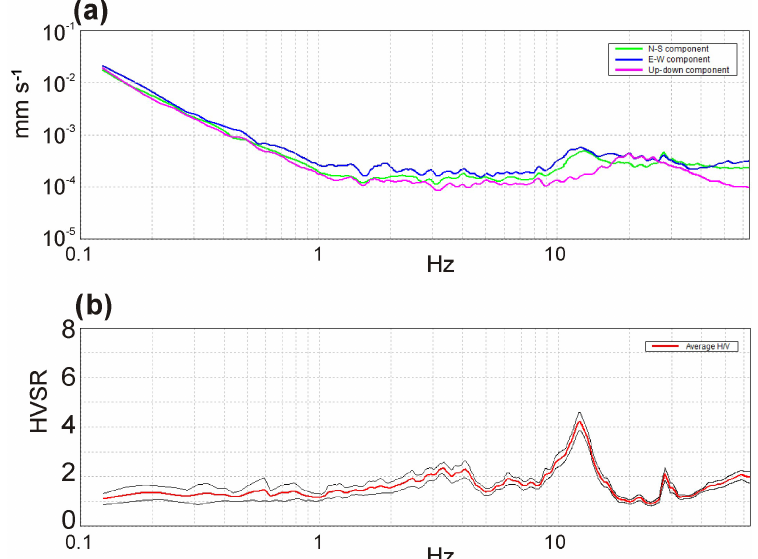
Figure 3. An example of microtremor horizontal-to-vertical spectral ratio (HVSR) analysis at point Id46. (a) Three amplitude spectral curves clearly shows the difference between both horizontal (N–S, E–W) and the vertical (up–down) component in a narrow frequency range. (b) Observed difference results in a clear peak on the HVSR curve at 12.3Hz. Thin lines represent the 95% confidence